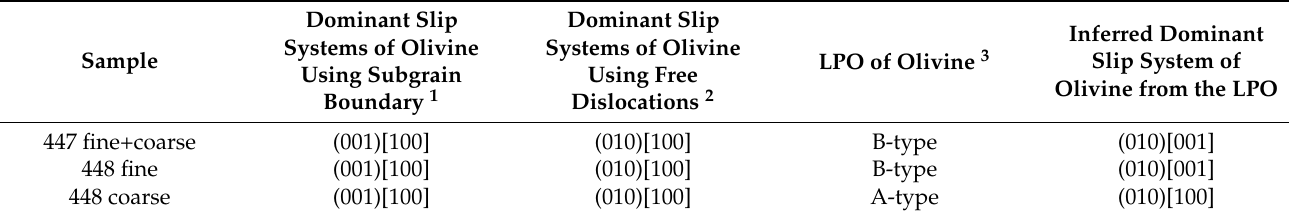
Table 2. Summary of the microstructural analysis of